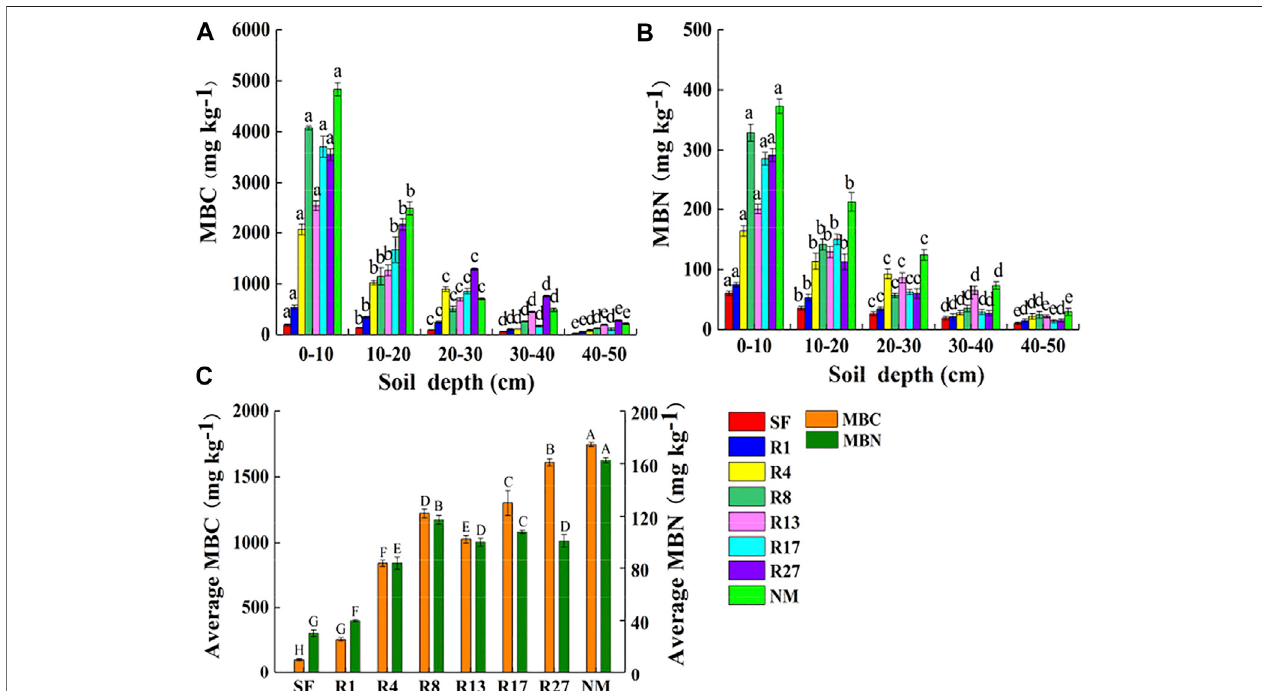
FIGURE2| DistributionofMBC (A) andMBN (B) at0 – 50 cmdepthofsoil,andtheaverageMBCandMBNcontentsindifferentsites (C) .SF,soybean fi eld;R1,R4, R8,R13,R17,and R27,restored sitesafter1,4,8,13,17,and 27 yearsoffarmlandabandonment;NM, naturalmarsh.Differentlowercaseletters in (A) and (B) indicate signi fi cant differences between different layers in the same site ( p < 0.05). Different uppercase letters in (C) indicate signi fi cant differences of the average value of the fi ve layers between different sites ( p <